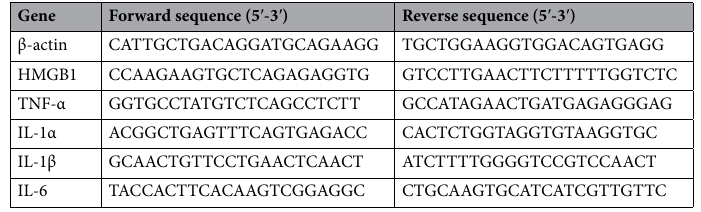
Table 1. Primer sequence for Real-time